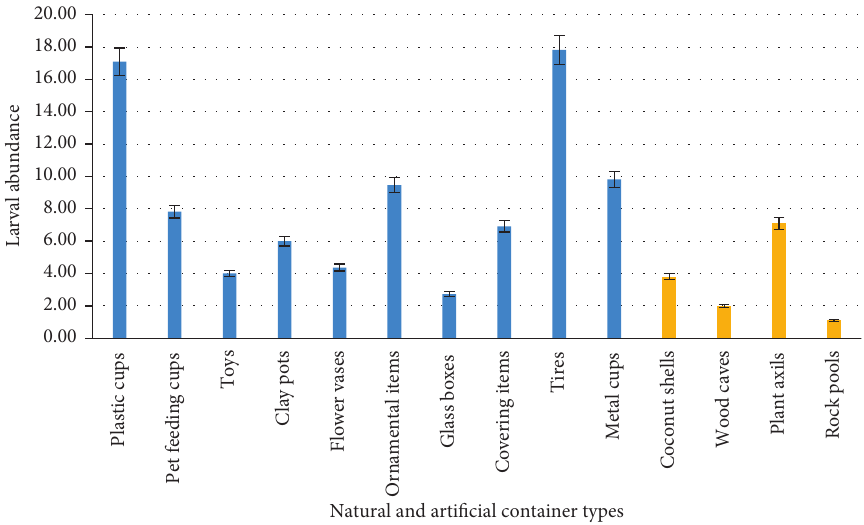
Figure 3: Relative abundance of Aedes aegypti larvae in natural containers and artificial